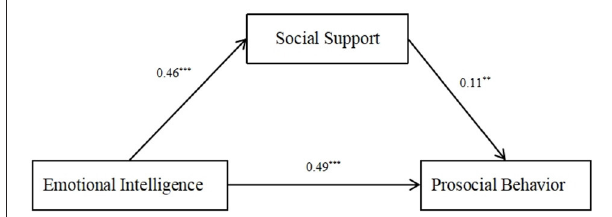
FIGURE 2 | Path models examining the mediation role of social support between emotional intelligence and prosocial behavior. Unstandardized coefficients are presented. *** p < 0.001, ** p <